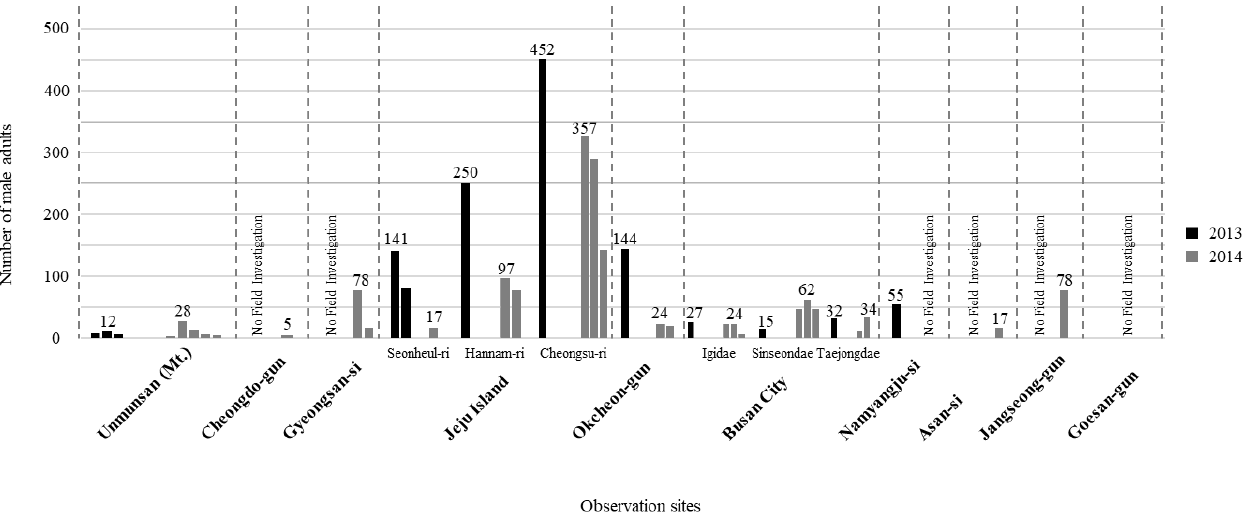
Figure 3. Population density of L. unmunsana in South Korea.